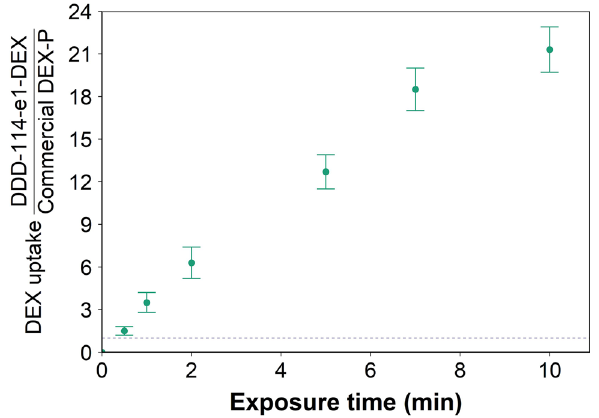
Figure 8. Uptake profile of DEX in cartilage using predicted best performing PBAE (DDD_114_e1-DEX).